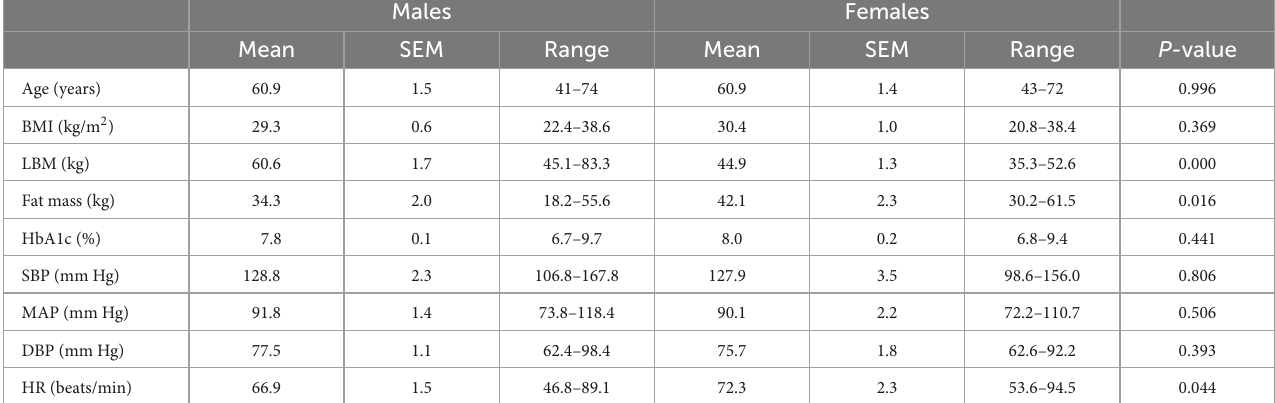
TABLE 1 Patients’ characteristics.